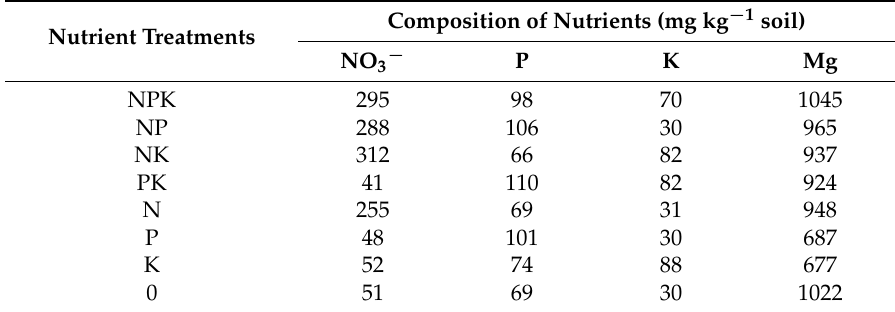
Table 3. Bulk soil matric potentials in pots of the different nutrient treatments on different harvest days. Soil Matric Potential (MPa) Drought Nutrient Treatments Days after Well-Watered